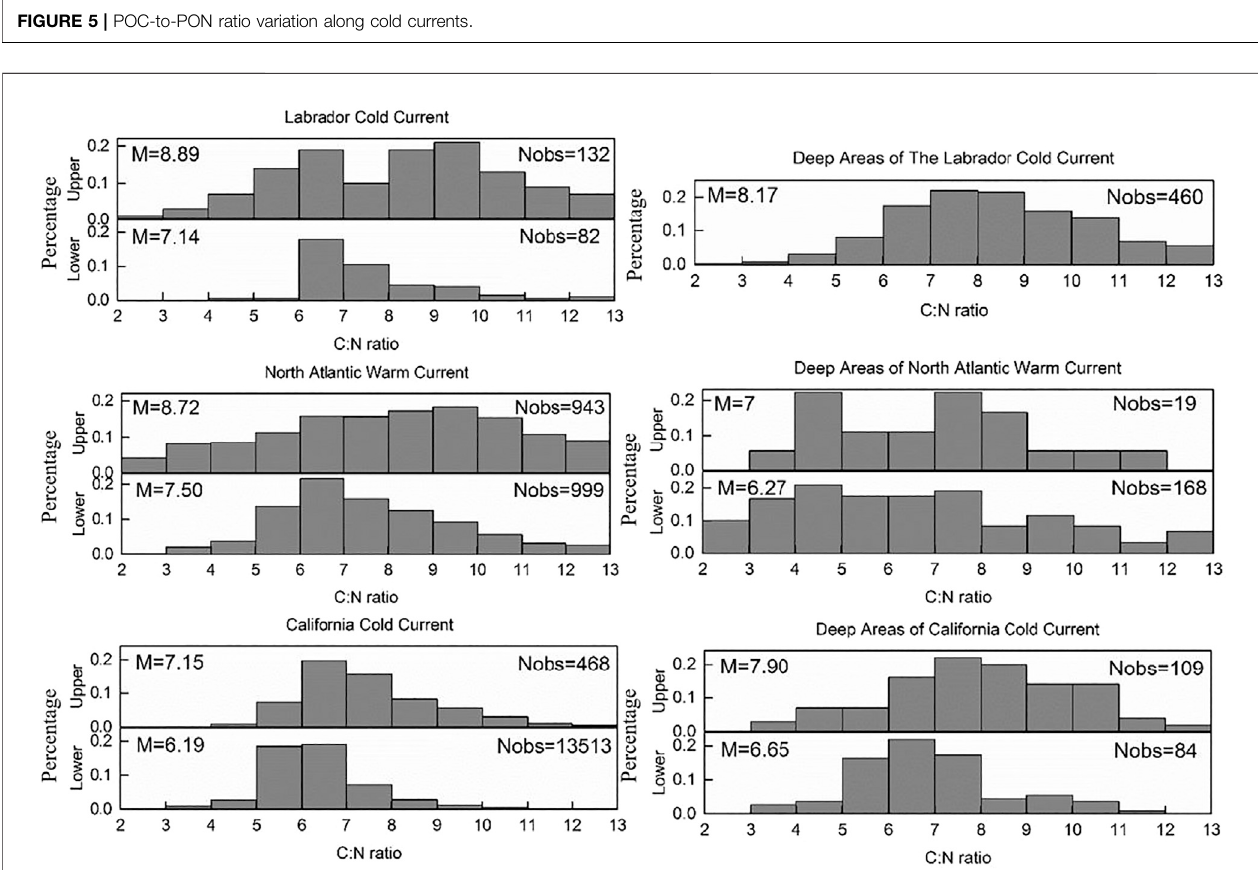
FIGURE 6 | Frequency of C-to-N ratio in deep water. M is the median ratio.